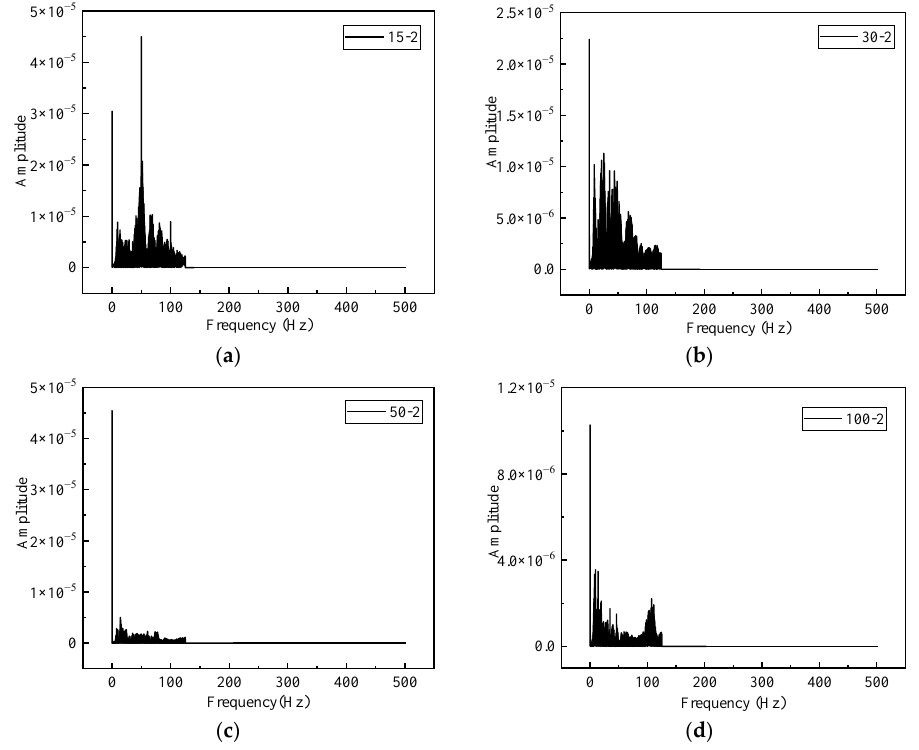
Figure 6. Acceleration time history curves in the east–west direction: ( a ) 15-2; ( b ) 30-2; ( c ) 50-2; ( d ) 100-2.